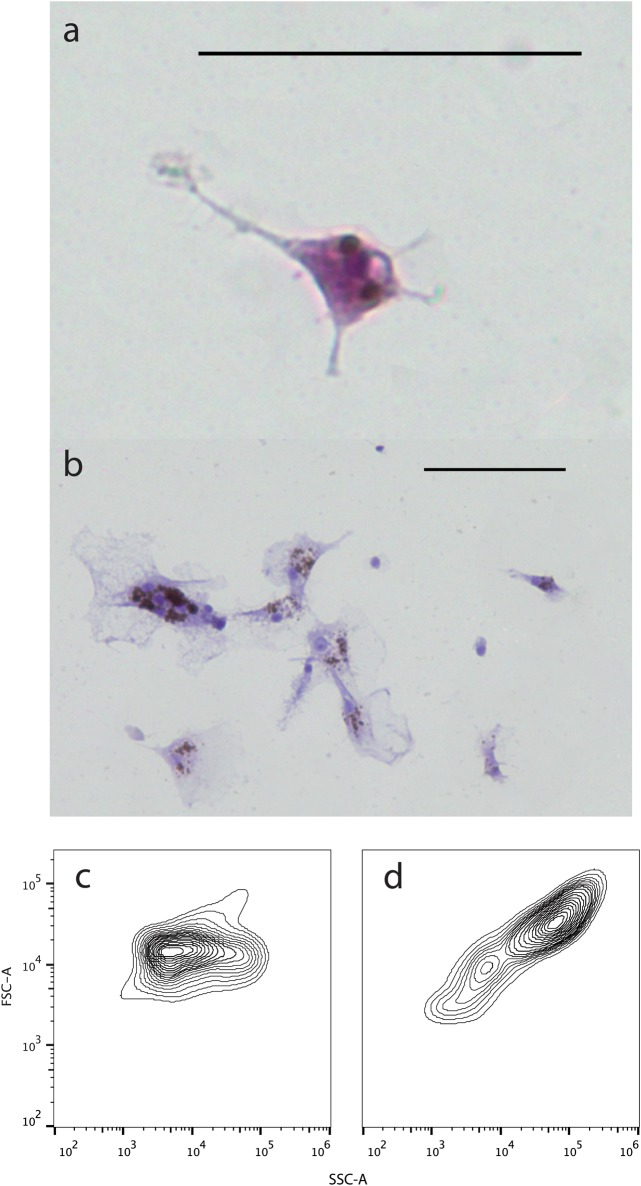
Barramundi DC morphology and isopycnic enrichment.(a-b) Dendritic-like cells isolated from L. calcarifer and stained with Hemacolour. (c) Forward and side scatter of barramundi spleen/HK cell populations before isopycnic enrichment and (d) after isopycnic enrichment.